Question: Sum up the contents of this chart in one sentence.
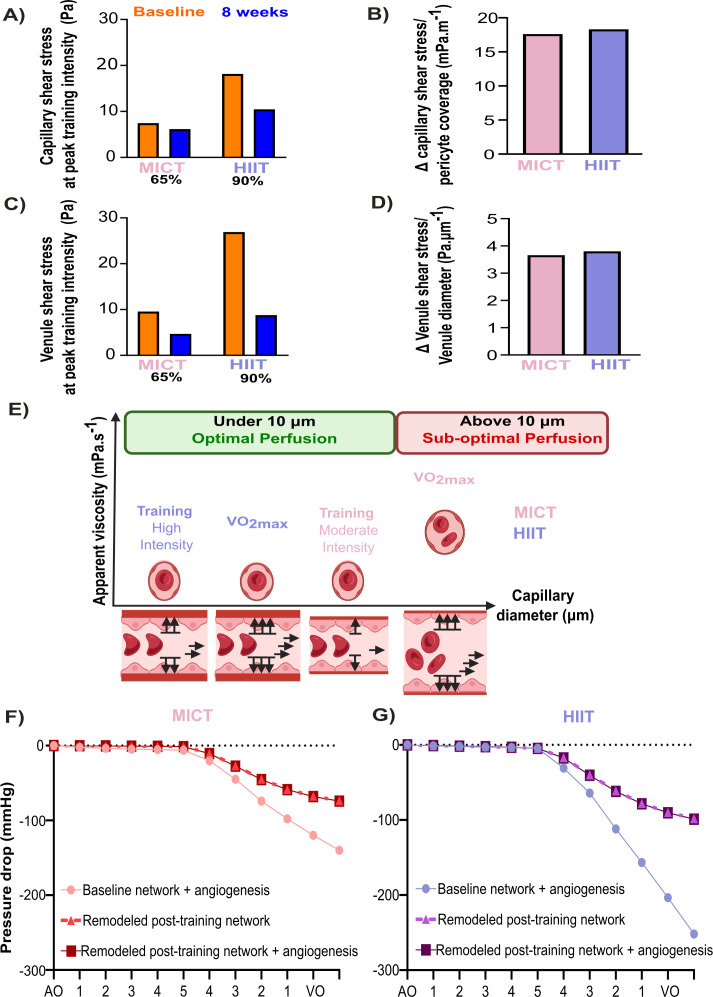
Answer: (A–D) show all shear stress values at peak training intensity (i.e. 65% HRmax for MICT and 90% HR max for HIIT). (A) displays capillary shear stress in both training group. (B) shows the ratio between training-induced changes in capillary shear stress and the relative variation in pericyte coverage following the 8-week intervention. (C) reports venular shear stress values across MICT and HIIT conditions. (D) illustrates the relationship between changes in venular shear stress and corresponding alterations in venular diameter. (E) characterizes apparent blood viscosity as a function of vessel diameter, highlighting red blood cell (RBC) morphology and axial positioning in capillaries below and above 10 mm in diameter. The number and orientation of flow vectors reflect the magnitude and directionality of local hemodynamic forces within the capillary bed. (F, G) illustrate the simulated pressure drop across the hemodynamic model under post-training maximal cardiac output. For each training condition, MICT in (F) and HIIT in (G) , pressure drop was calculated in: (1) the baseline vascular network with simulated angiogenesis (+12.5% capillary expansion), (2) the post-training remodeled vascular network, and (3) the post-training remodeled vascular network with additional simulated angiogenesis (+12.5%), allowing comparison of how isolated angiogenesis versus vascular remodeling influenced hemodynamic efficiency under maximal flow conditions.